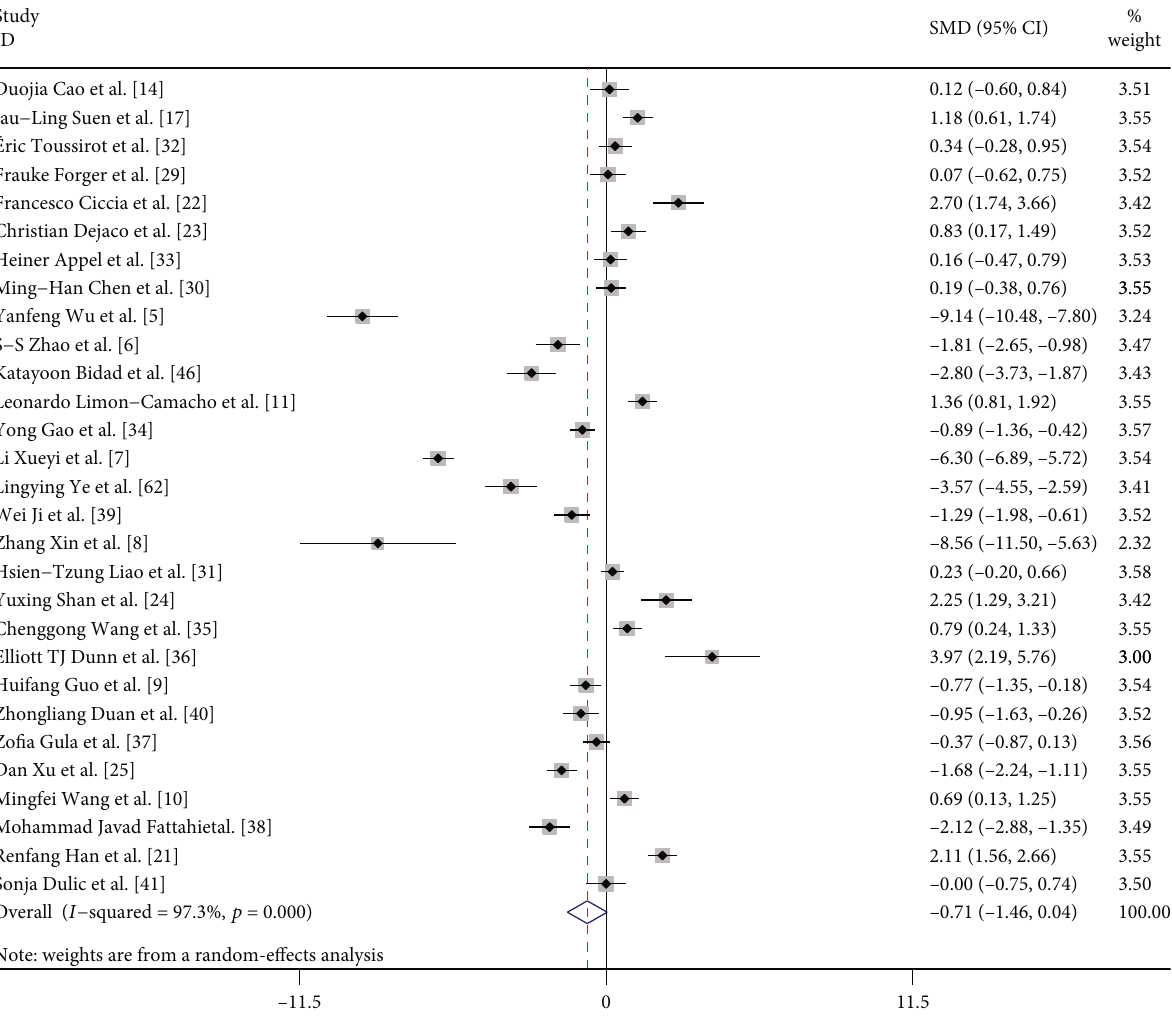
Figure 2: Forest plot of the overall meta-analysis of regulatory T cell (Treg) proportions in peripheral blood (PB), regardless of the Treg de fi nitions used, between ankylosing spondylitis (AS) patients and healthy blood donors